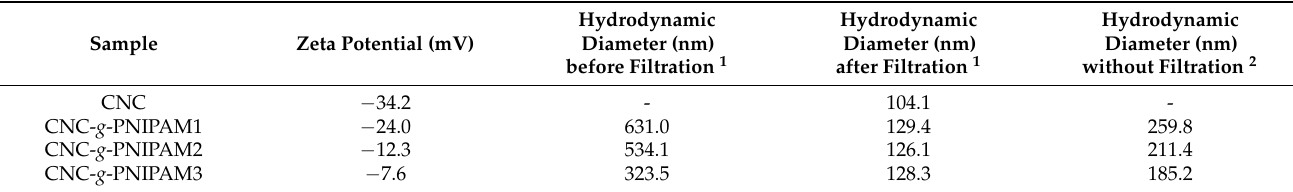
Table 1. Zeta potential (mV) and hydrodynamic diameter (nm) of unmodified and functionalized CNCs particles in distilled water.